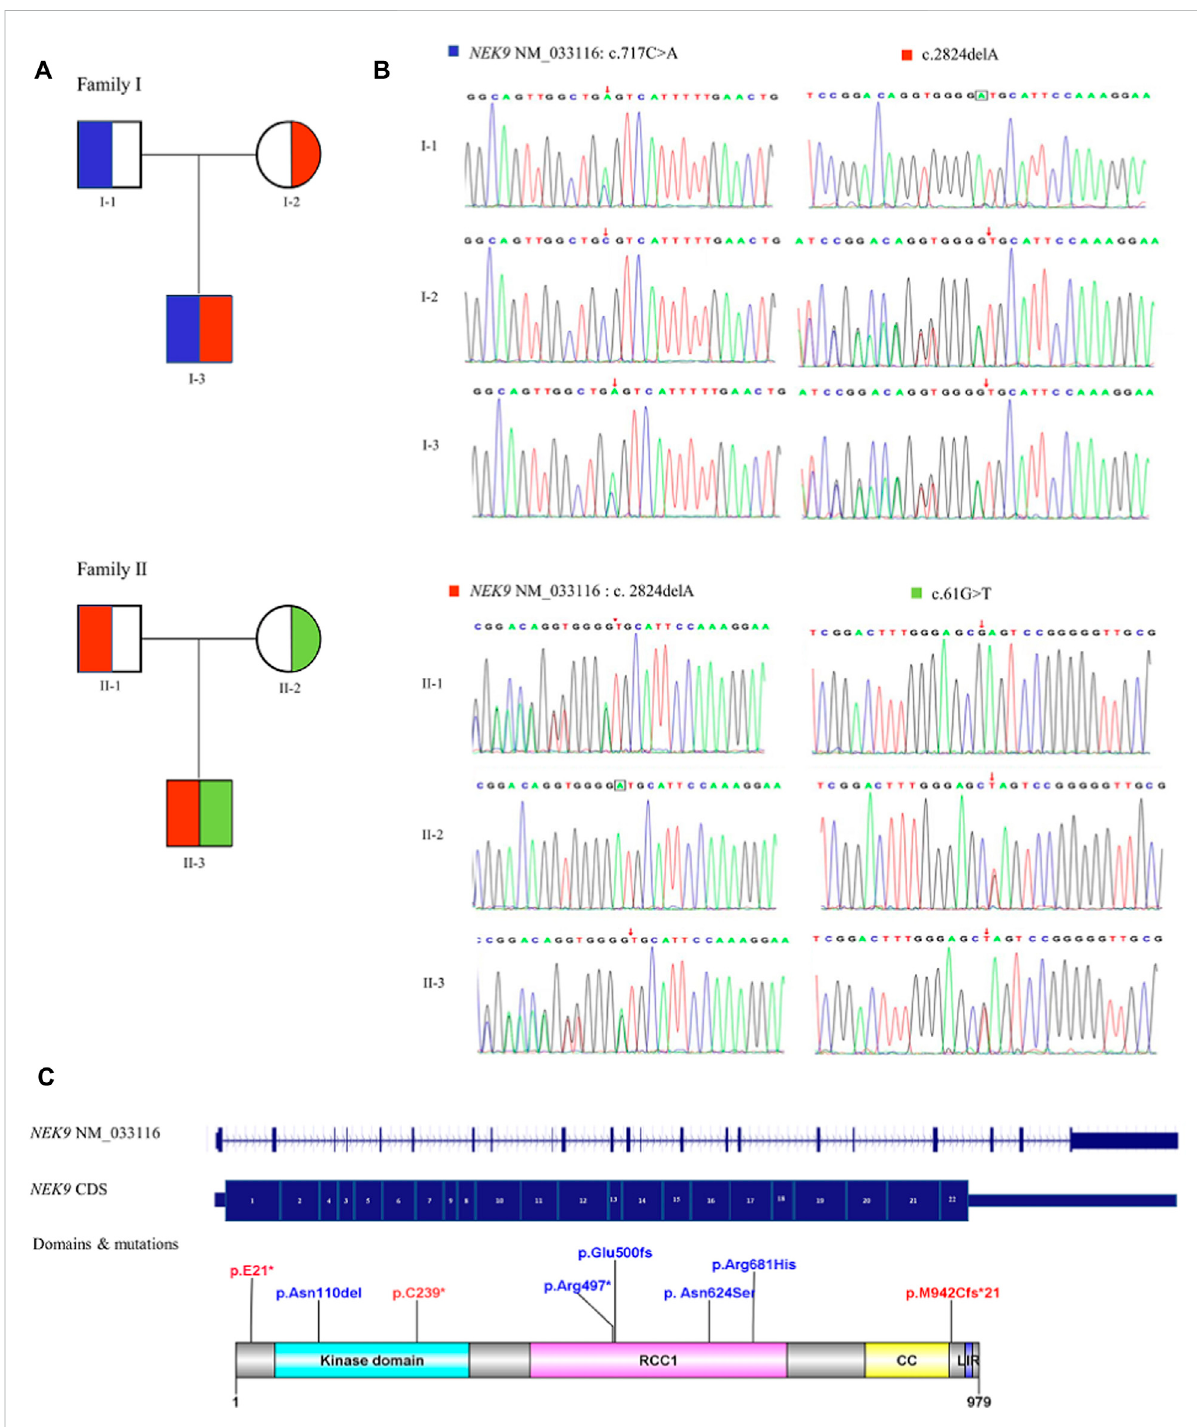
FIGURE 2 Diagram of NEK9 mutations and gene structure. (A) Pedigree diagrams oftwo families with NEK9 mutations. Each color correspondsto anovel variant of NEK9 . (B) Sanger sequencing results of the diagnostic variants in the two families. (C) Distribution diagram of domains and mutations associated with lethal congenital contracture syndrome 10 (LCCS10, OMIMZ# 617022) and arthrogryposis, Perthes disease, and upward gaze palsy (APUG,OMIMZ# 6142622) in serine/threonine-protein kinase NEK9 . RCC1, RCC1-repeats; CC, coiled-coil domain; and LIR, LC3-interacting